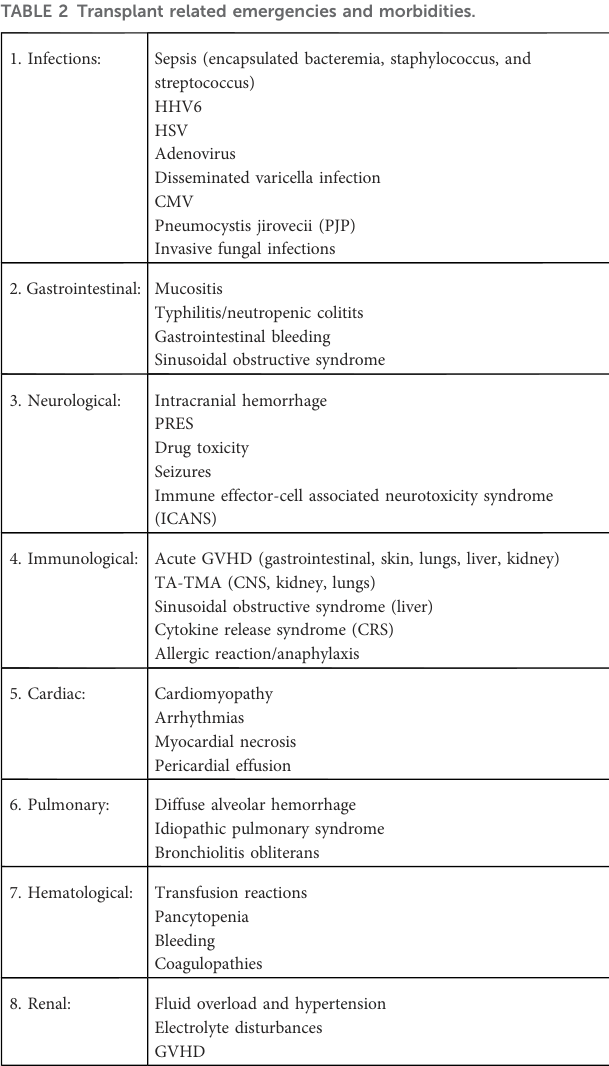
TABLE 2 Transplant related emergencies and